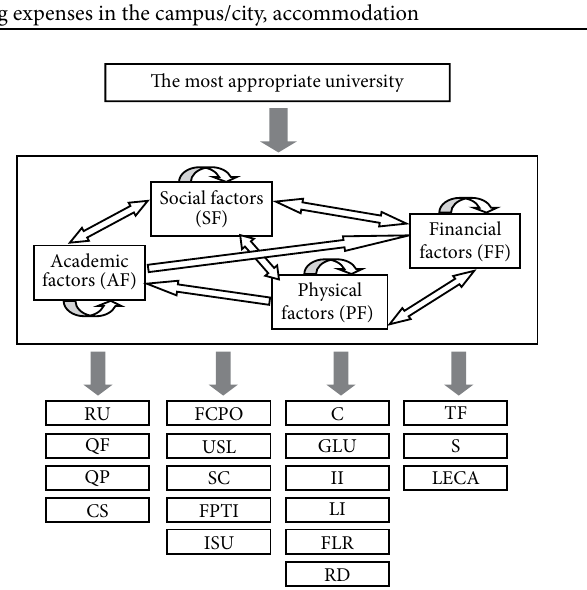
Fig. 2. The proposed ANP model for